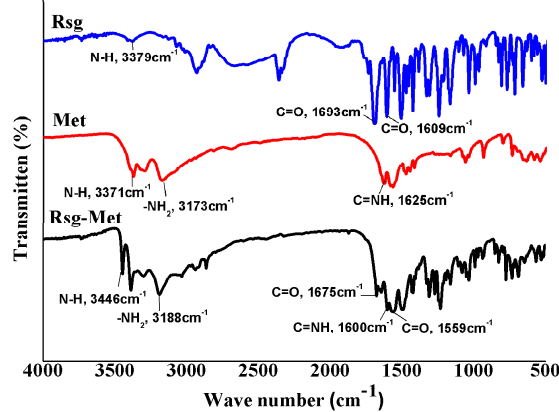
Figure 5. The FT-IR spectrum of Rsg, Met, and Rsg-Met.